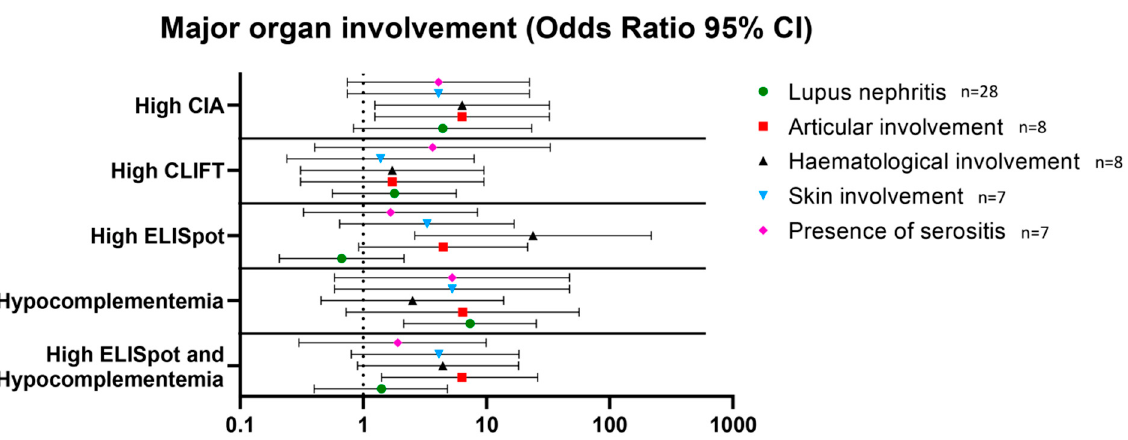
Figure 3. Association between high levels of anti-dsDNA antibodies measured by CIA, CLIFT and ELISpot and hypocomplementemia and major organ involvement. Results are expressed as odds ratios and 95% confidence intervals. Abbreviations: CIA: chemiluminescence immunoassay; CLIFT: Crithidia luciliae indirect immunofluorescence test.